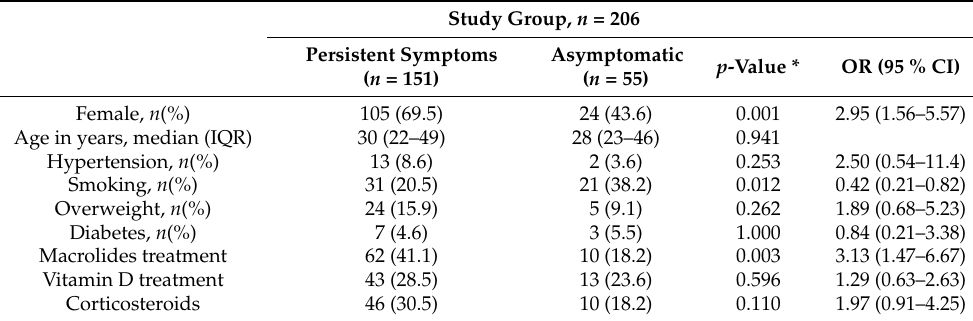
Table 2. Influence of gender, comorbidities, and treatment on the persistence of symptoms in outpatients who had recovered from COVID-19.